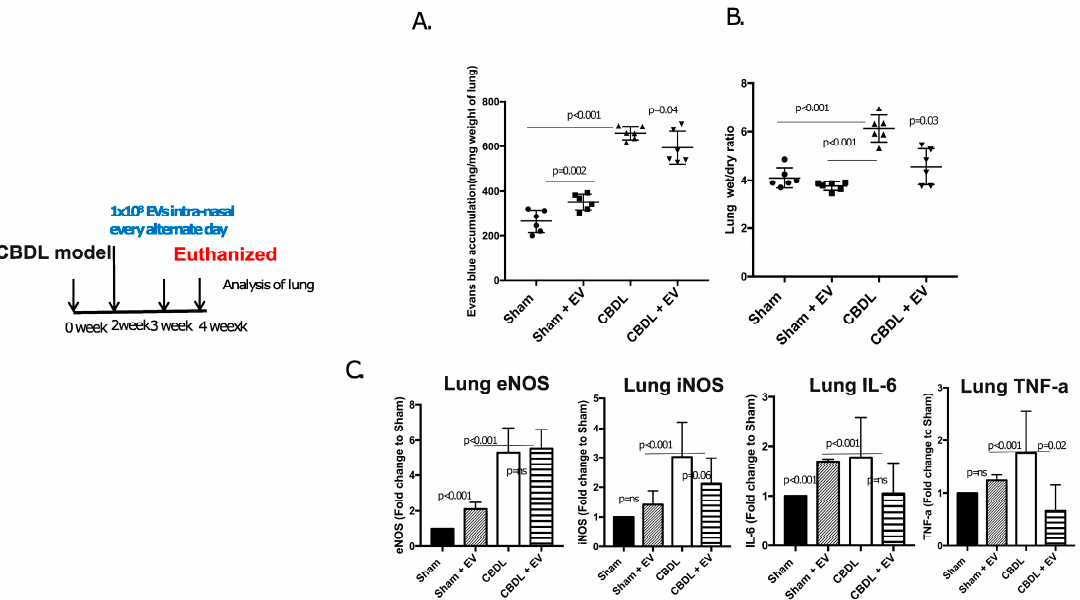
Figure 4. Extracellular vesicles (1 × 10 8 EV/ µ L) obtained from healthy WT mice were administered intranasally into CBDL mice (2 weeks post-surgery of CBDL) every day for 2 weeks. ( A ) The bar diagrams show the Evan blue accumulation in lungs and ( B ) liver/body weight in sham-operated and CBDL mice with and without EVs. ( C ) Bar graphs show the fold changes in mRNA candidate genes associated with vasodilators and inflammation.